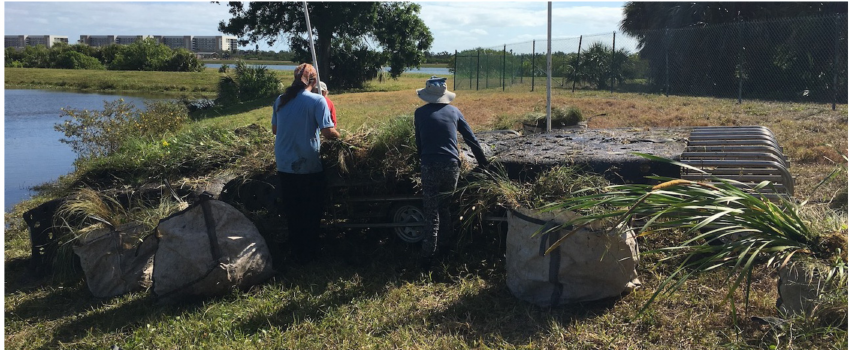
Figure 2. Harvest platform for removing plants from floating treatment wetlands (FTWs). Plants removed from the FTW scaffold were placed into